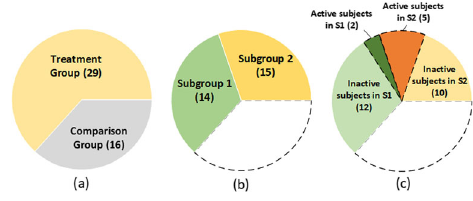
Fig. 5 Subjects in experiment ( ‘ 17). a Treatment vs. comparison group. b Subgroup 1 vs. Subgroup 2. c Active vs. Inactive subgroups. Numbers in brackets are group